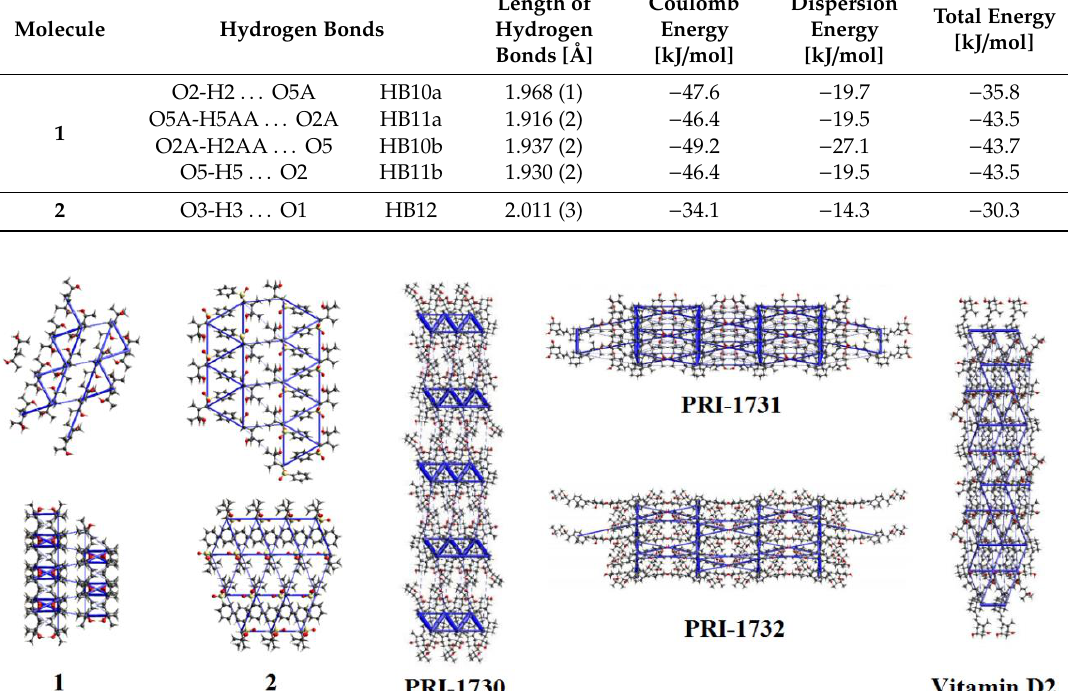
Figure 5. Energy frameworks for 1 , 2 , and vitamin D analogues. Results for all frameworks were presented for the total energy, using the scale factor equal to 50, and the value of energy threshold was equal to 5 kJ/mol.